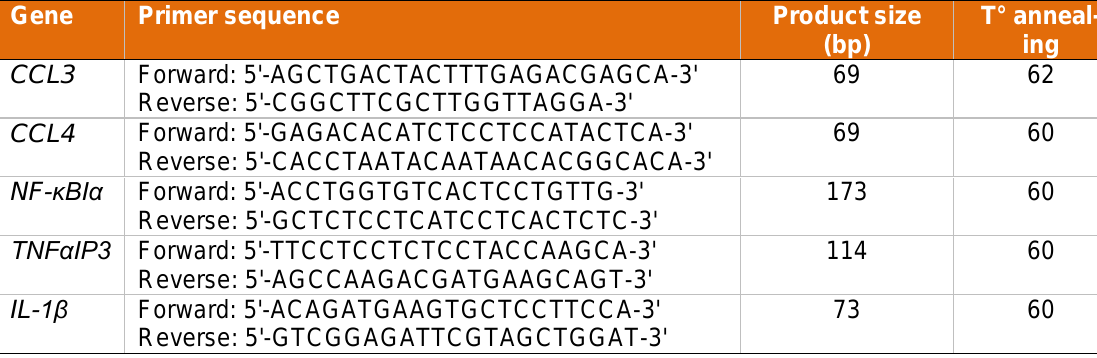
Table 1: Primers used for real-time-PCR analysis